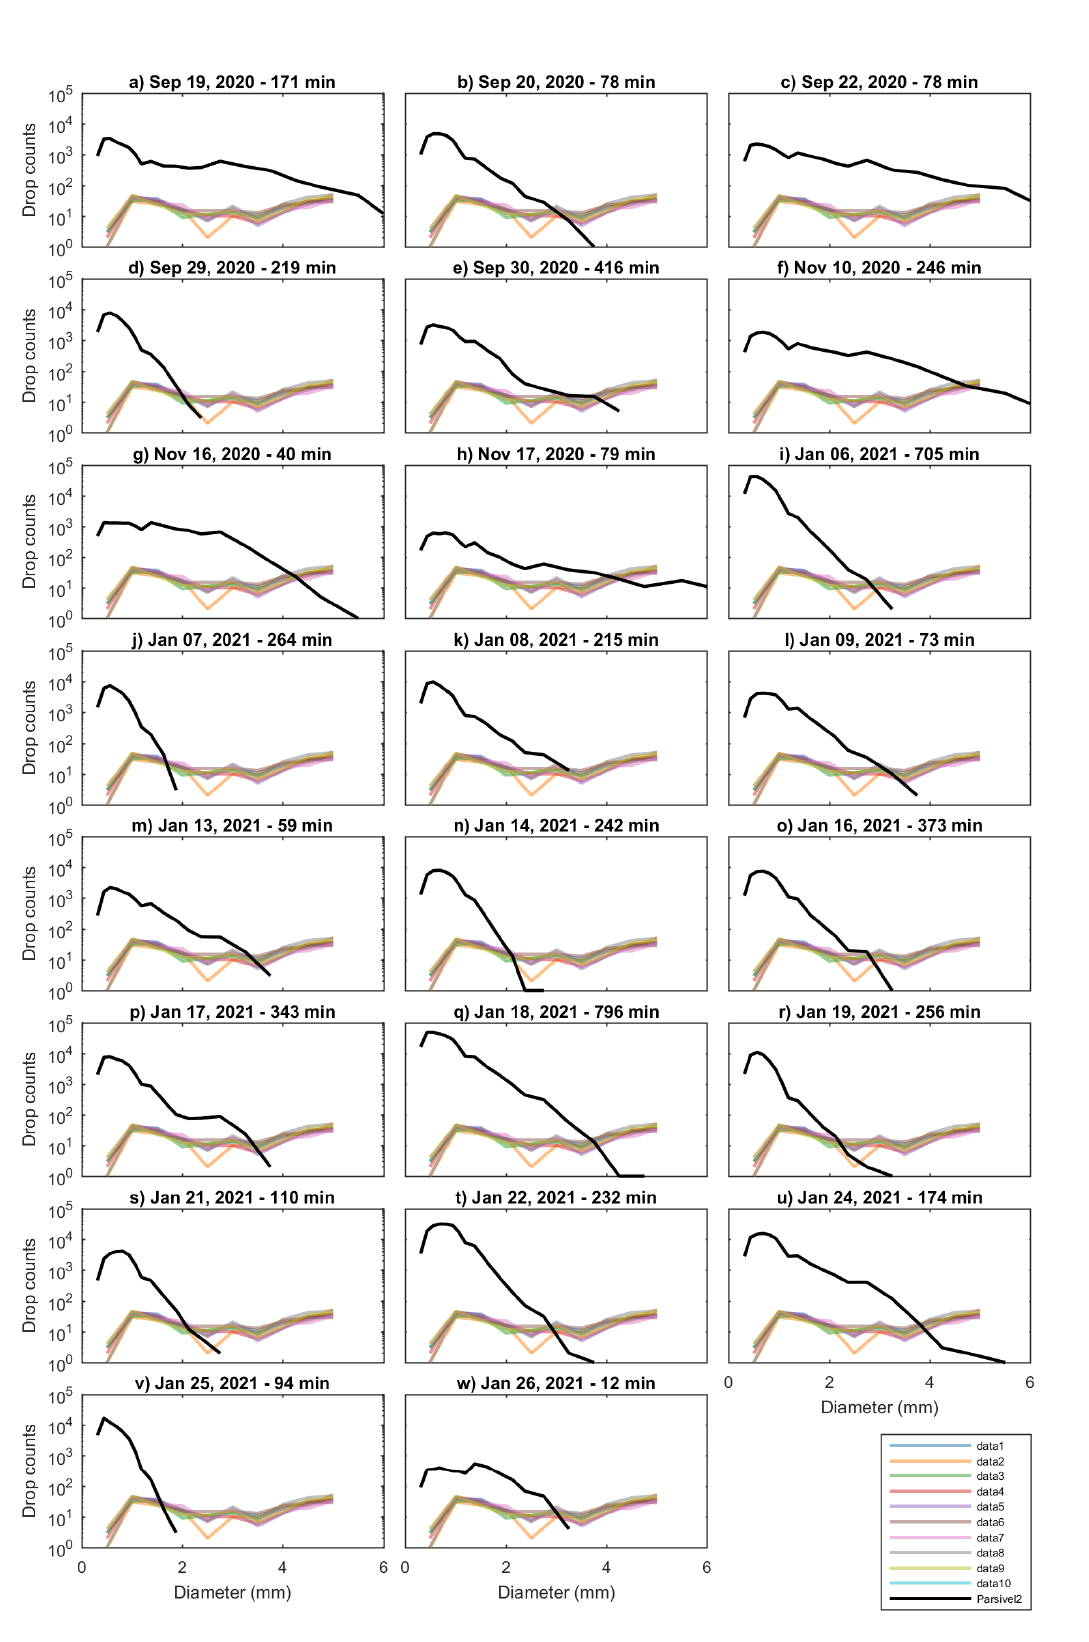
Figure 10. Drop size distribution measured by Parsivel 2 (black line) and WS100 sensors (color lines) for 23 rainfall events. From ( a – w ), the DSD for each event is